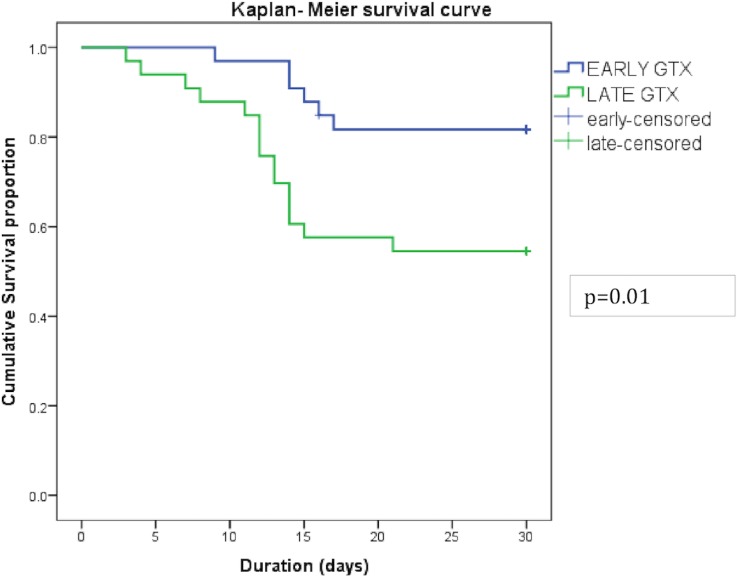
Kaplan Meier survival curves for infectious episodes (IEs) given GTX before 7 days versus those given GTX ≥7 days.